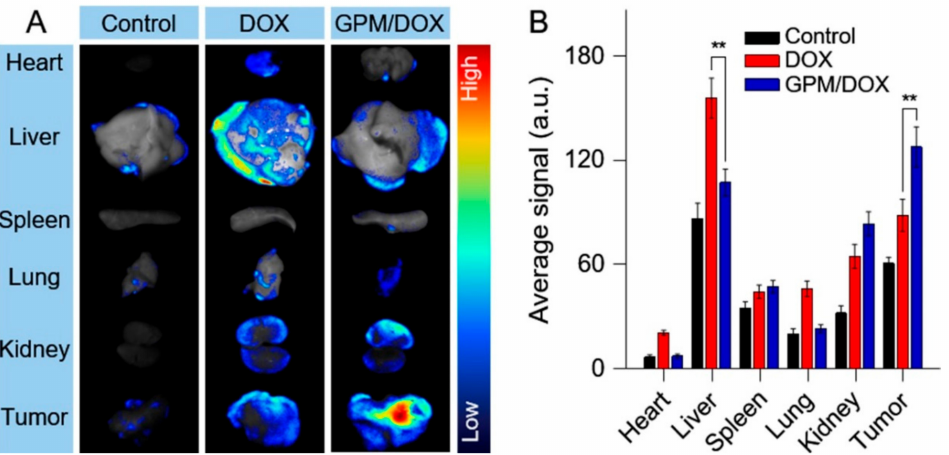
Figure 3. ( A ) Ex vivo DOX fluorescence images showing the semiquantitative tissue distribution of DOX; and ( B ) the average strength collected from the major organs (i.e., heart, liver, spleen, lung, and kidney) and tumors after i.v. injection of normal saline, GPM/DOX, or free DOX to H22-xenografted Kunming mice for 12 h; data were presented as a mean ± SD ( n = 3; ** p <